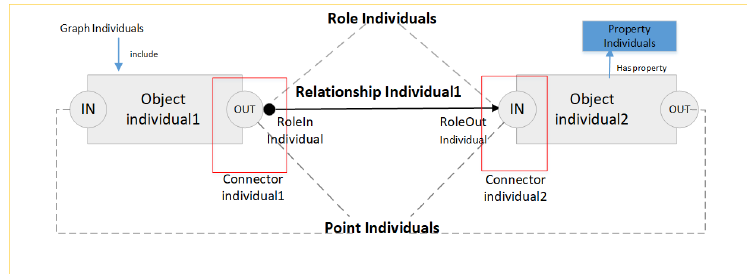
Figure 7. GOPPRRE ontology to represent model topology.